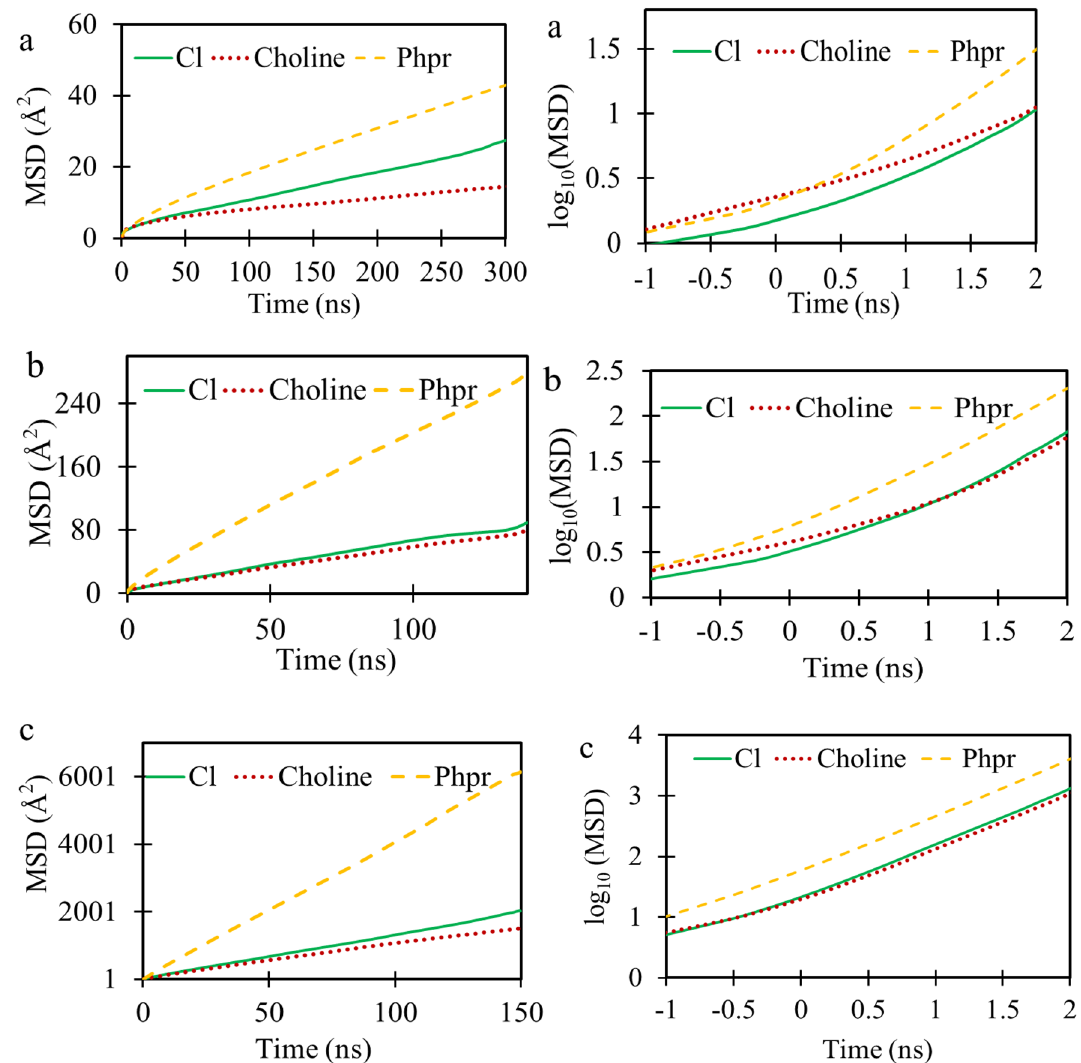
Figure 9. The linear (left panel) and logarithm scale (right panel) of the center of mass MSD for species were calculated using the VMD package 40 at the temperatures; 293 K: ( a ), 321 K: ( b ) and 400 K: ( c